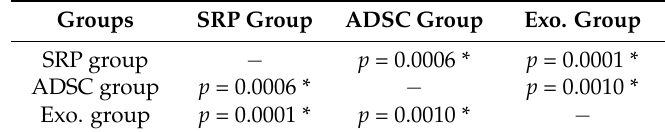
Table 4. Pairwise comparison of mean area % values of newly formed tissues for the studied groups after 4 weeks (post hoc Tukey test).